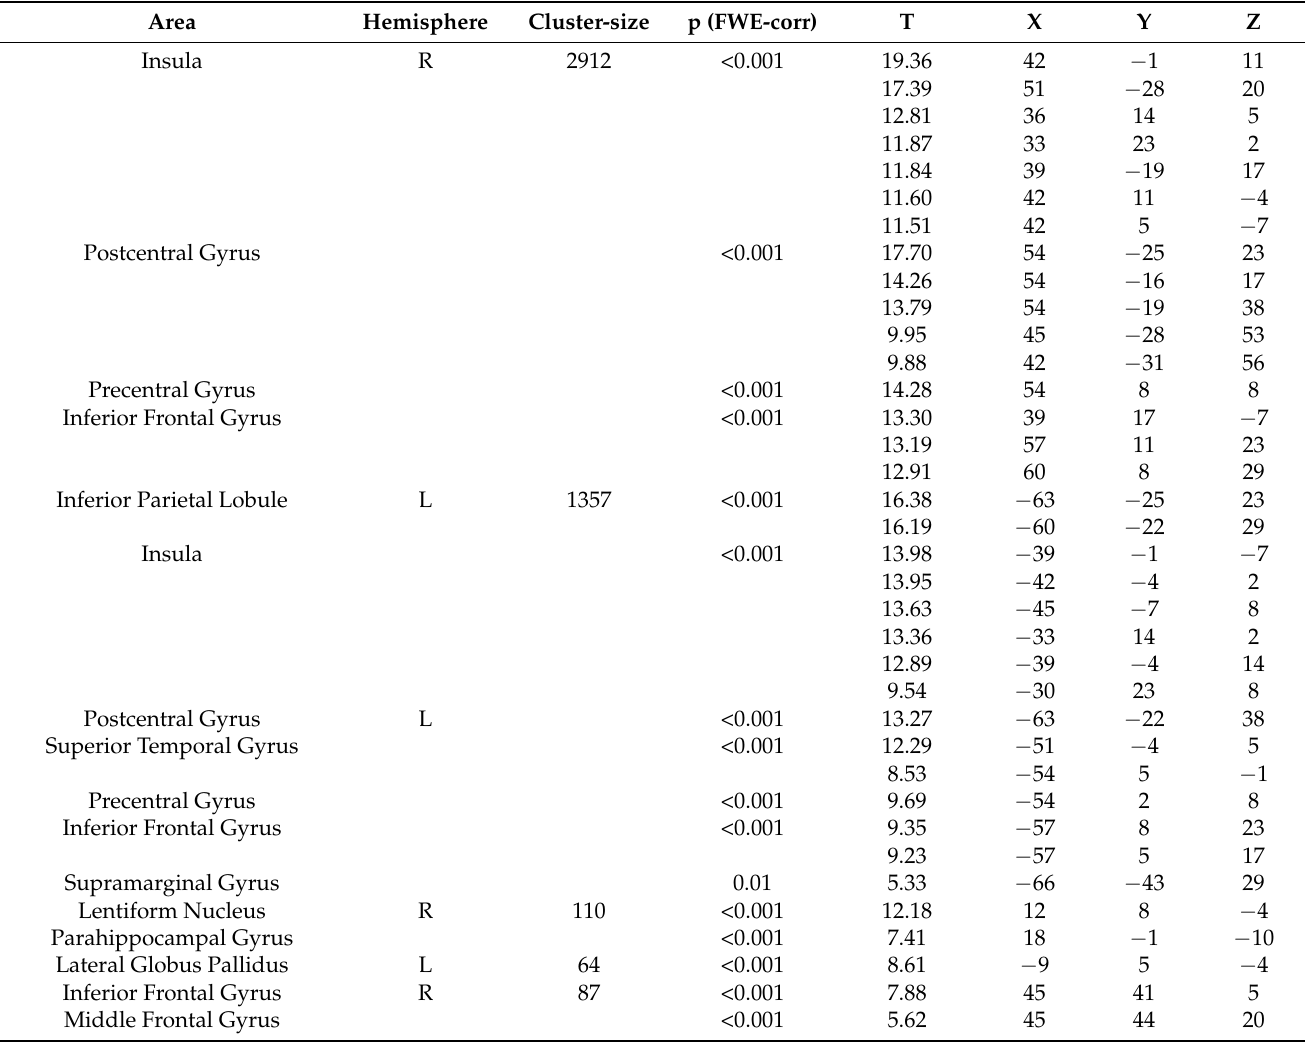
Table 3. Main effect of low and high pressure combined. R = right, L = left, FWE-corr = family-wise-